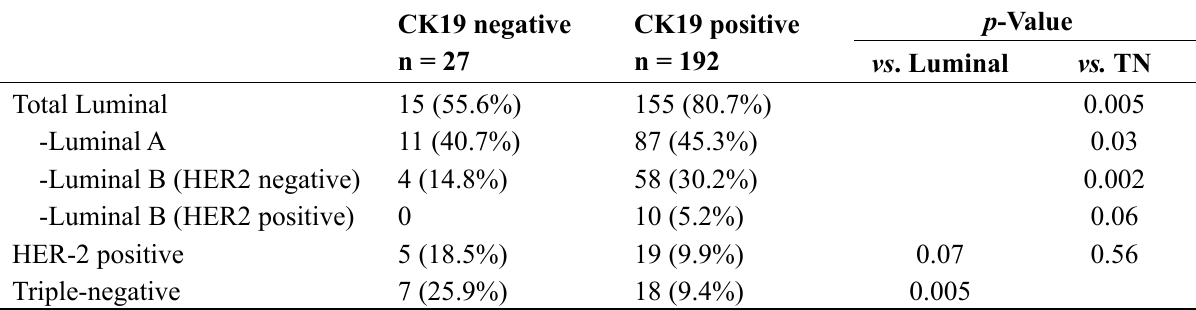
Table 3. CK19 expression status and subtypes.